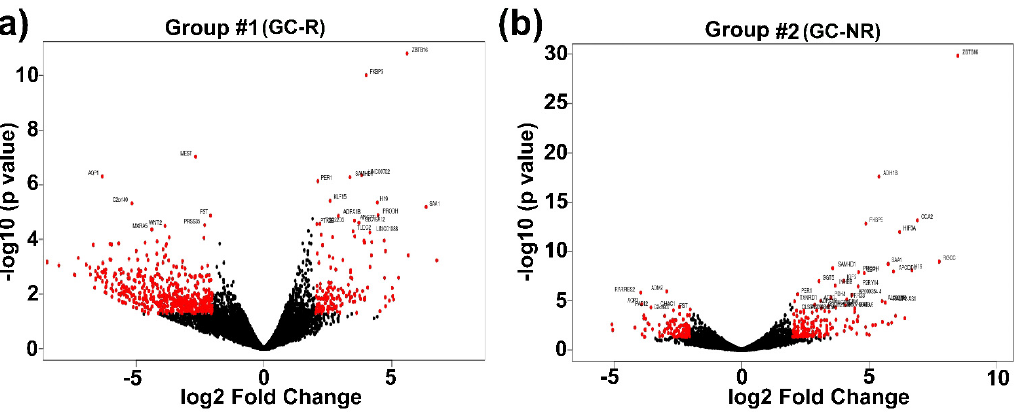
Figure 2. Volcano plot showing the distribution of DEGs The fold of change (log2) and p -value (-log10) of differentially expressed genes from ( a ) Group #1 and ( b ) Group #2 are represented. Red color indicates the significantly dysregulated genes with an absolute fold change >2 and p -value: <0.05. Note: Group #1: DEGs between DEX- and ETH-treated GC-R HTM cells; Group #2 DEGs between DEX- and ETH-treated GC-NR HTM cells.